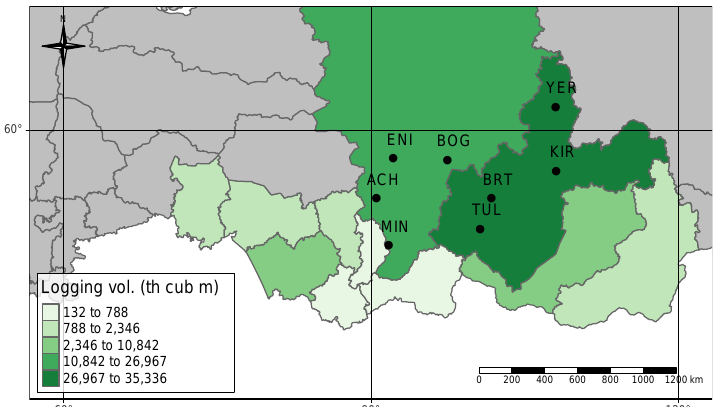
Figure 1. Study sites and spatial distribution of logging volumes by Siberian regions in 2018 (thousands cubic meters). Note: developed by authors using R and sf , tmap , and rnaturalearth packages [34–37]. Data source: Rosstat